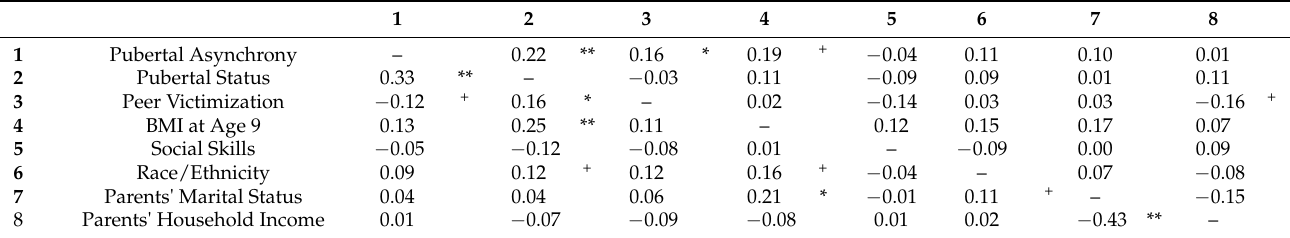
Table 3. Inter-Correlations Between Study Variables.